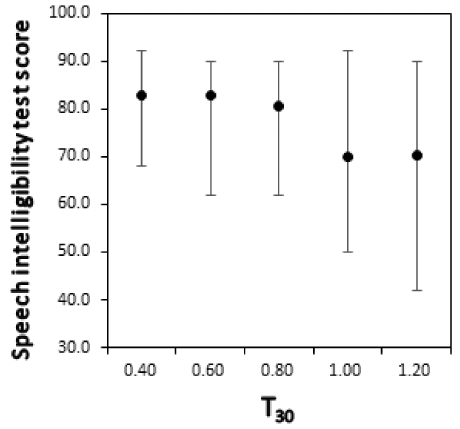
Figure 10. Comparison of speech intelligibility scores with RT.